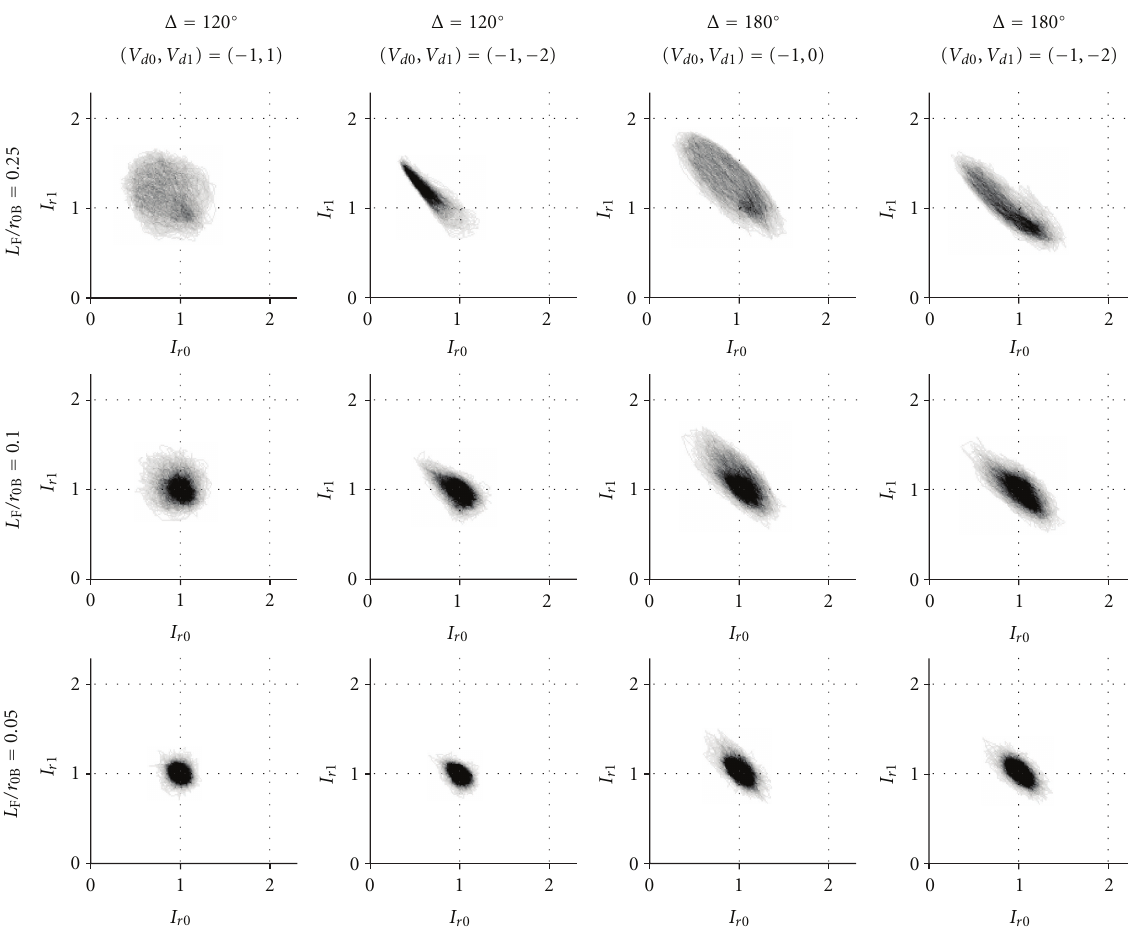
Figure 12: The same data as in Figure 9 but obtained with M outer = 20 r 0 B